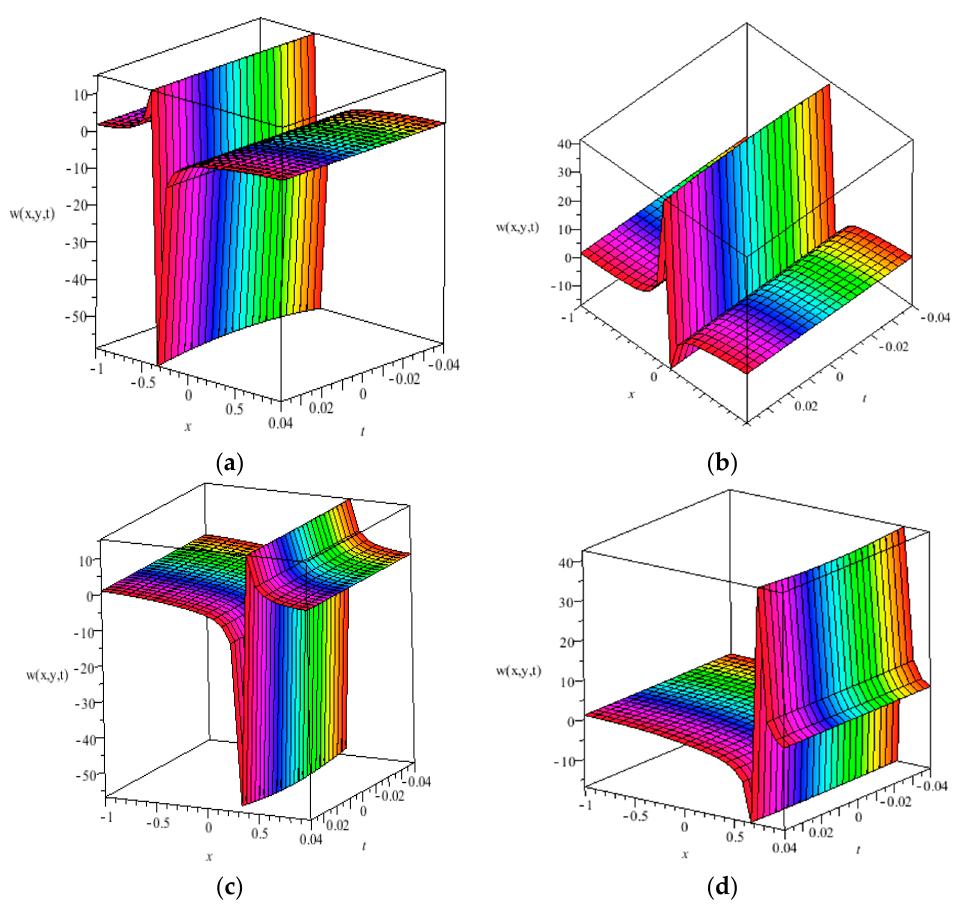
Figure 3. ( a ) A positive solution of Equation (1.3) at c = 0; ( b ) a positive solution of Equation (1.3) at c = 1; ( c ) a negative solution of Equation (1.3) at c = 0; ( d ) a negative solution of Equation (1.3) at c = 1.